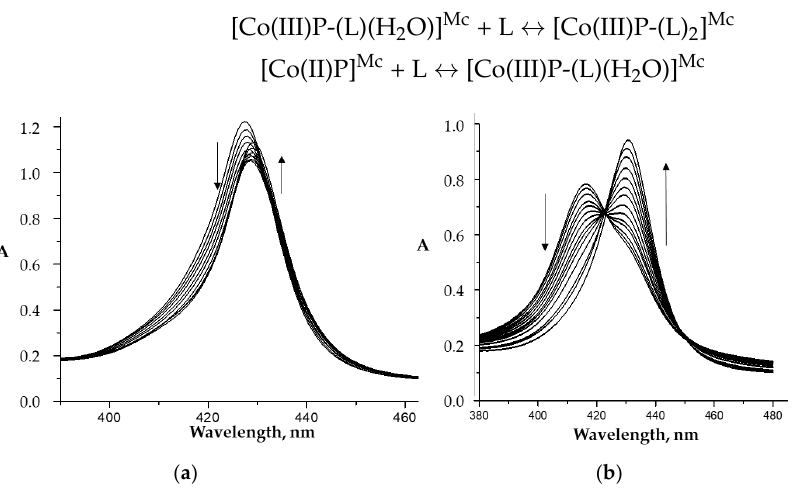
Figure 11. UV–Vis spectra (Soret band region) of the [Co(III)P1-(H 2 O) 2 ] Mc ( a ) and [Co(II)P1] Mc ( b ) upon titration with L1 (C CPC = 0 ÷ 8 × 10 –4 M, in phosphate buffer (pH 7.4) at 25 ◦ C).